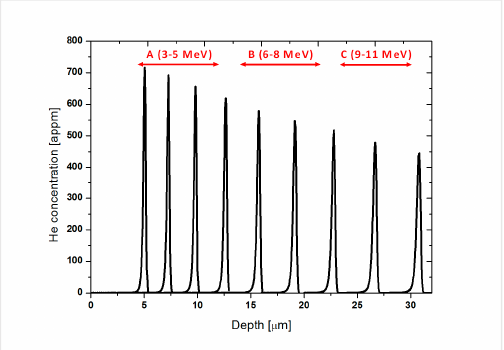
Figure 2. Hardness values vs. distance from the implanted surface of ( a ) EU-ODS EUROFER and ( b ) EUROFER97 irradiated with He from 2 to 15 MeV: Black dotted line represents the values for the annealed state at 450 °C for 100 h. Red dotted are the hardness values for the implanted at RT previous annealing and blue dashed line represents the as received hardness values. All the measurements were performed at 5